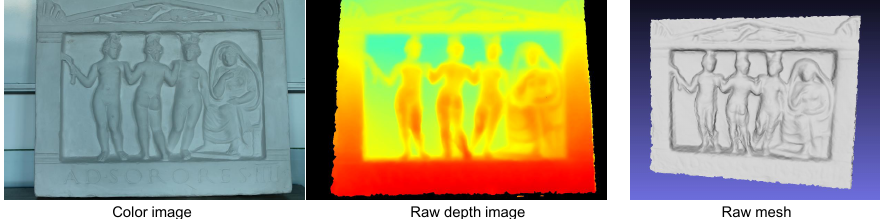
Figure 7. The Relief dataset. From left to right are the color and raw depth images for the fourth view, as well as the initial reconstruction from [36].